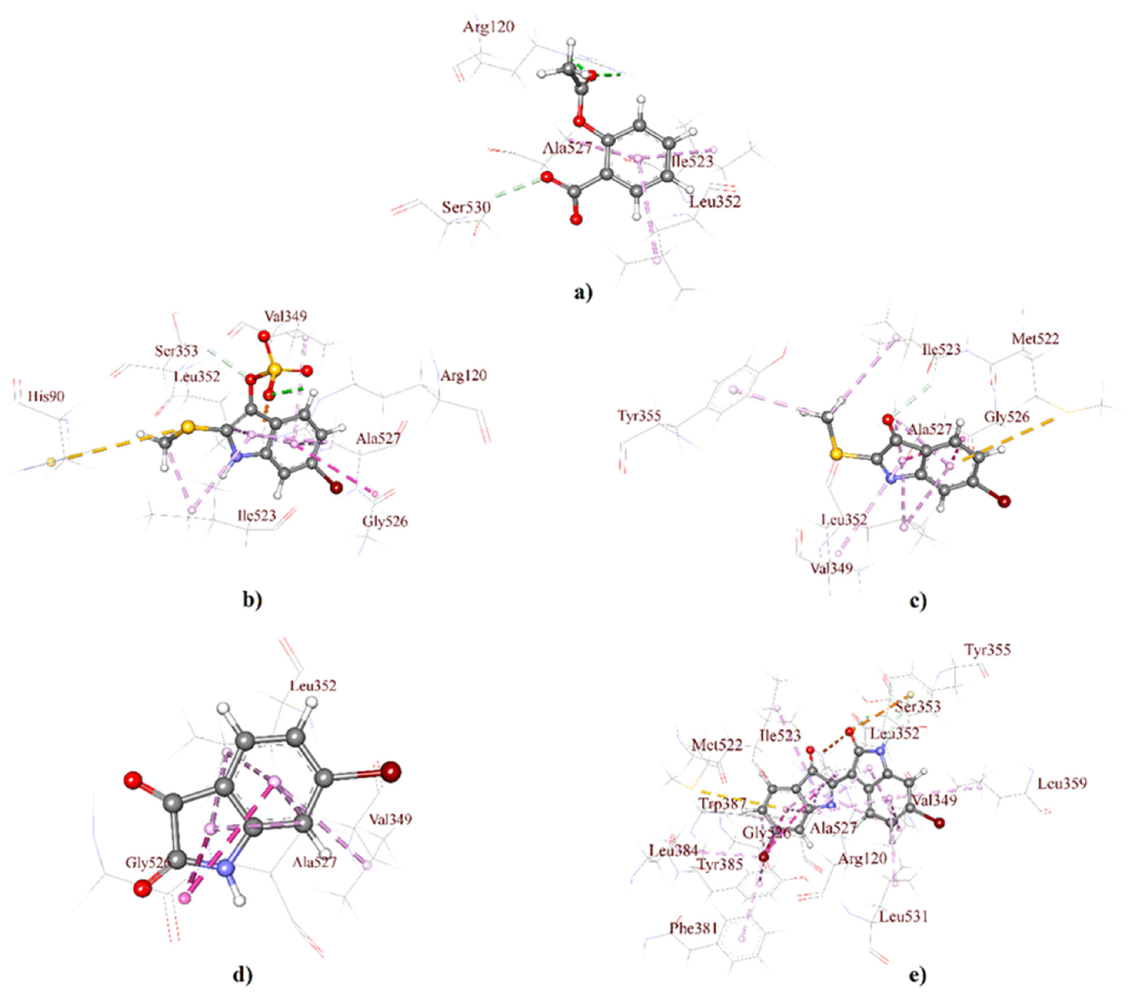
Figure 2. 3D interaction maps (distances Å) of Dicathais orbita brominated indole derivatives and standard aspirin showing the crystallographic ligand with a COX-1 active binding site; ( a ) aspirin, ( b ) tyrindoxyl sulfate, ( c ) tyrindoleninone, ( d ) 6-bromoisatin, and ( e ) 6,6’-dibromoindirubin.